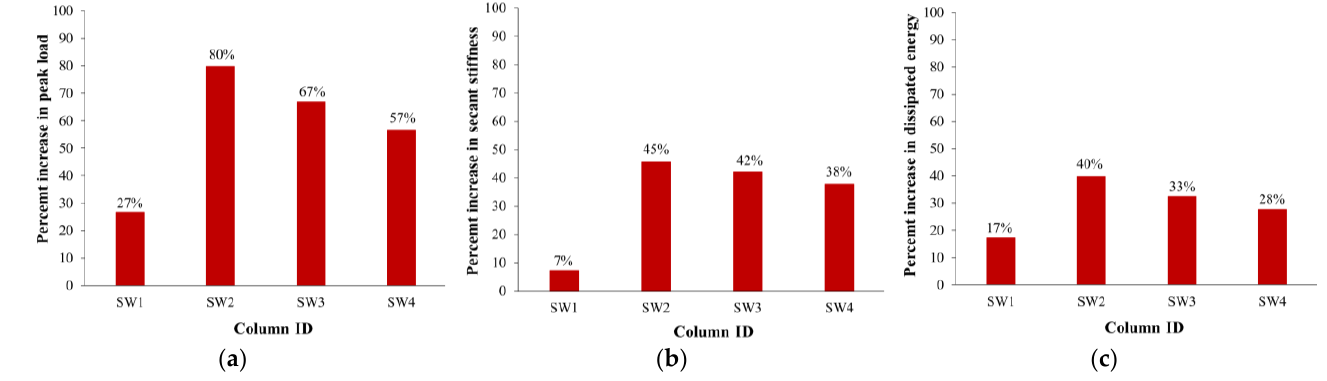
Figure 14. Comparison of strengthened columns with respect to percent enhancement in: ( a ) maxi- mum load; ( b ) stiffness; and ( c ) energy dissipated.